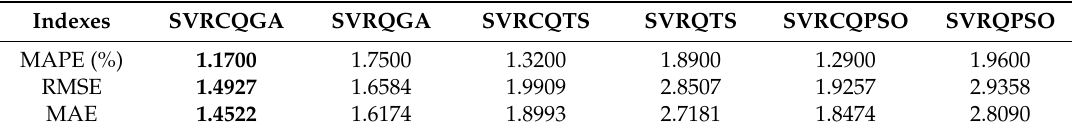
Table 9. Forecasting indexes of SVRCQGA, SVRQGA, and other models (Example